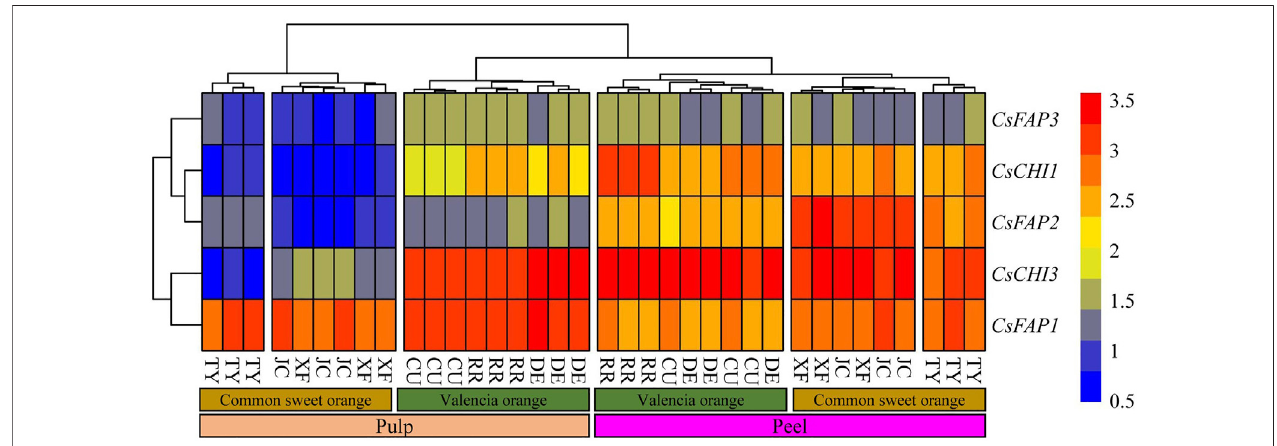
FIGURE 5 | Expression pattern of CHI genes in pulp and peel. RR represents “ Rohde Red Valencia, ” DE represents “ Delta Valencia, ” CU represents “ Cutter Valencia, ” , XF represents “ Xianfeng, ” JC represents “ Jincheng, ” and TY represents “ Taoye ” oranges.